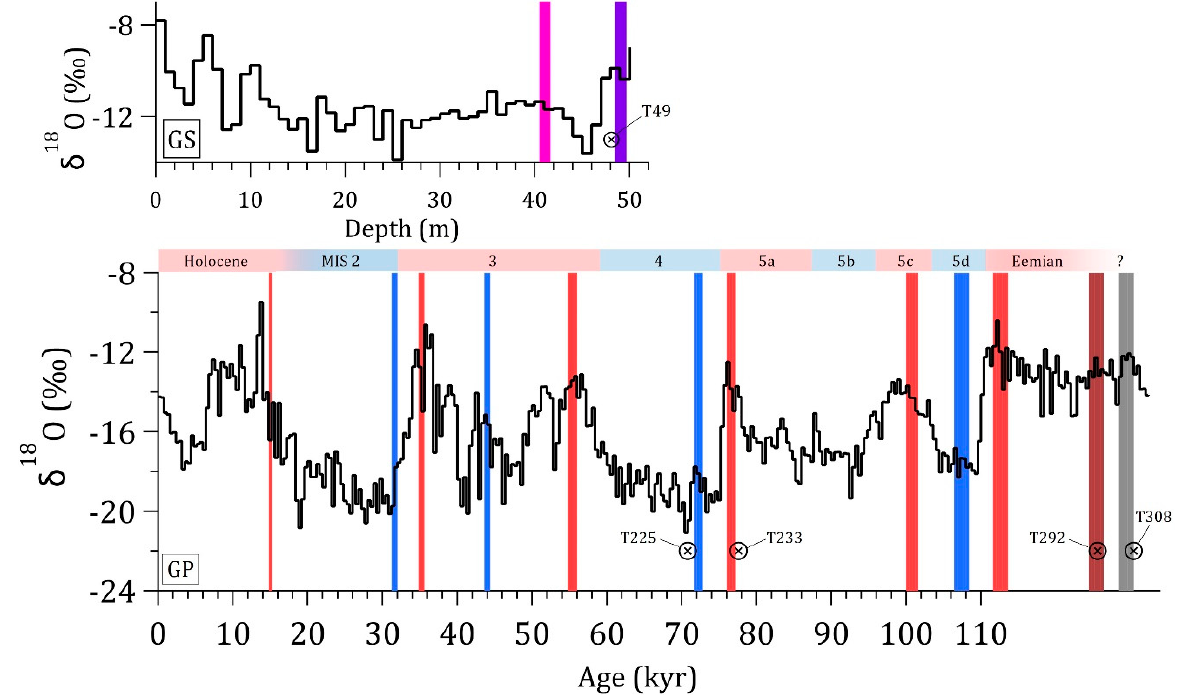
Figure 2. 5 m-averaged δ 18 O record vs. depth of the Guliya 2015 Summit core (GS) (upper panel); δ 18 O time series of the 1992 Plateau core [11] illustrating the climatic periods recorded in the Guliya Plateau (GP) ice core (lower panel) as defined by [11]. The vertical bars mark the 1 m ice core sections sampled for microparticle concentration and size, and trace element concentrations in ice corresponding to “warm” (purple/red) or “cold” (pink/blue) periods. The bars are increasingly wider with age (and depth) as 1 m of ice comprises more time toward the bottom of the glacier due to the increased thinning of successive ice layers with depth. Note that the vertical bars representing T290 and T292 (brown), and T305 and T306 (grey) are juxtaposed and therefore appear as two bars instead of four on the time axis. The crossed circles indicate the depth at which dust filtrate from 1 m ice sections were collected on filters (i.e., dust filter samples) for geochemical and isotopic analyses (see Table 1).